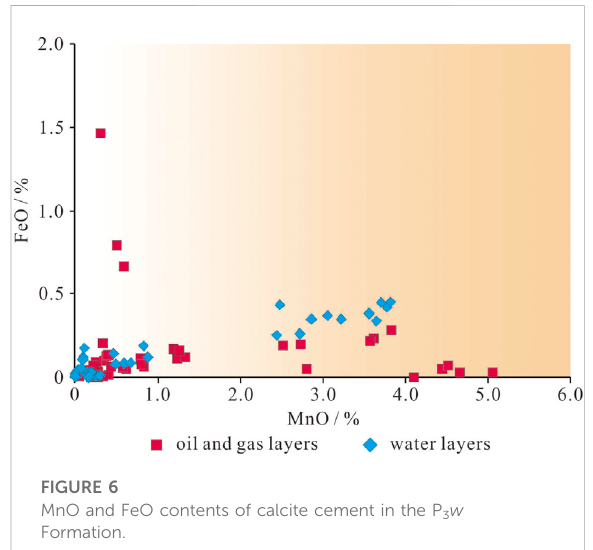
FIGURE 6 MnO and FeO contents of calcite cement in the P 3 w